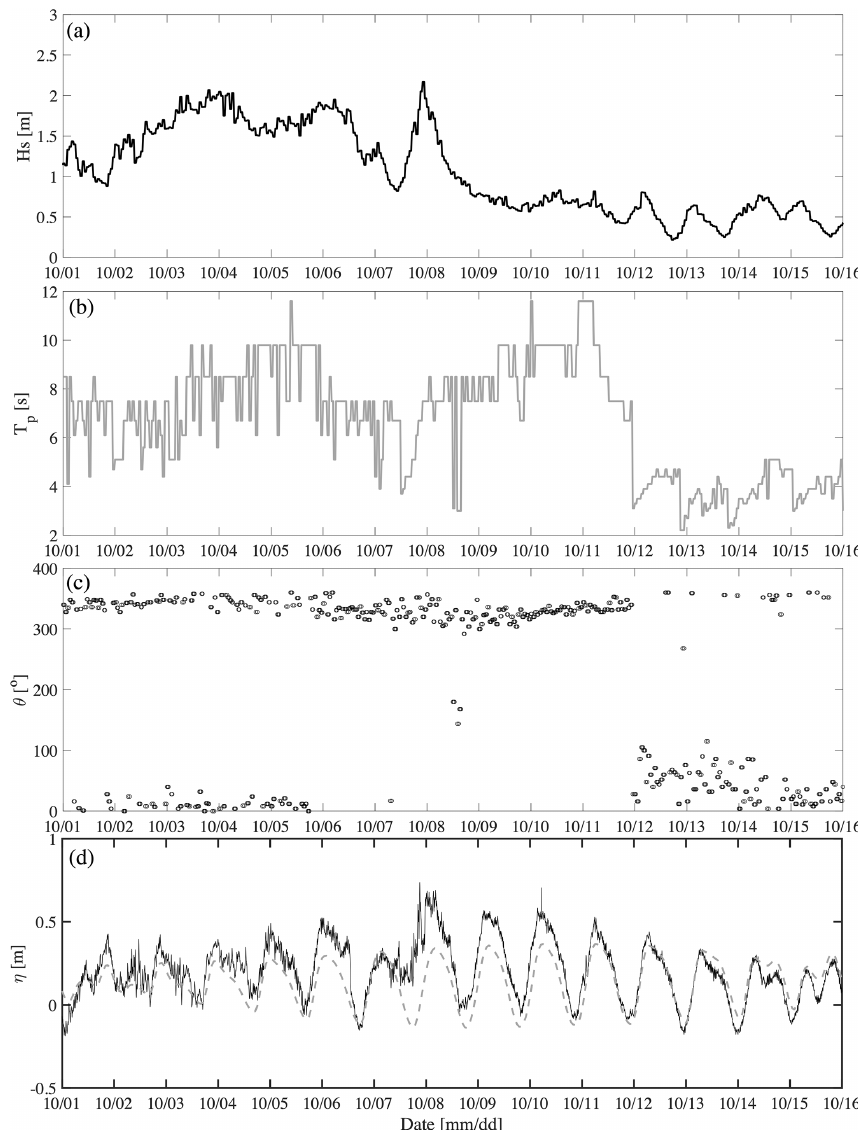
Figure 5. Time series of (a) significant wave height, (b) peak wave period, (c) mean wave direction measured at the ADCP deployed 10km offshore, and (d) mean sea level (measured: solid line; predicted: dashed